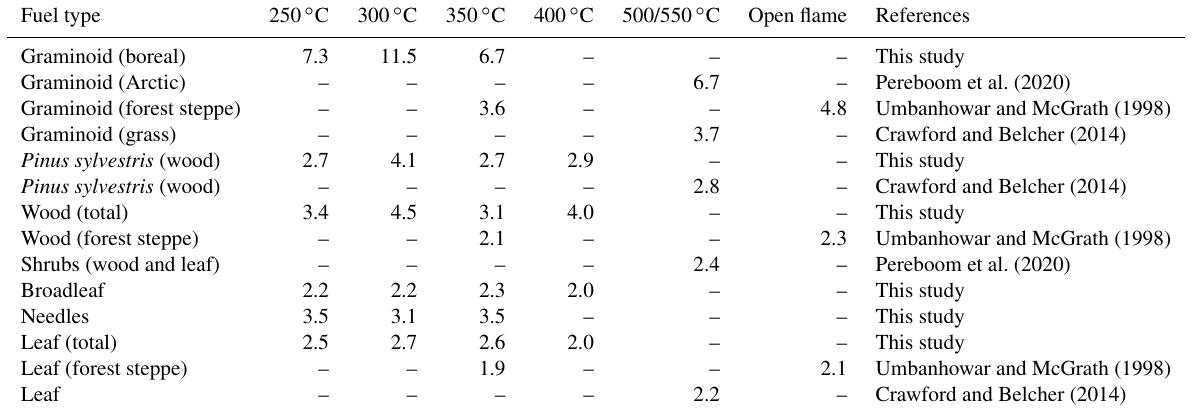
Table 4. Comparative results of the aspect ratio from plant species analysed in this study with those from literature. “ Pinus sylvestris (wood)” sums the mean aspect ratio of wood from trunk and twig; “Wood (total)” sums the mean aspect ratio of wood from trees and shrubs (trunk and twig); “Broadleaf” sums the mean aspect ratio of leaf from trees and shrubs, whereas “Leaf (total)” averages the mean aspect ratio of all leaf